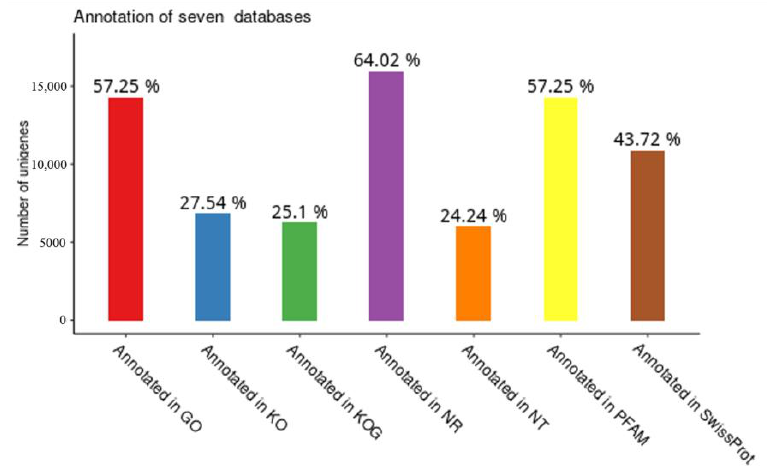
Figure 7. The functional information diagram of unigenes of P. kessleri FACHB-3316 in the annotation of seven databases.